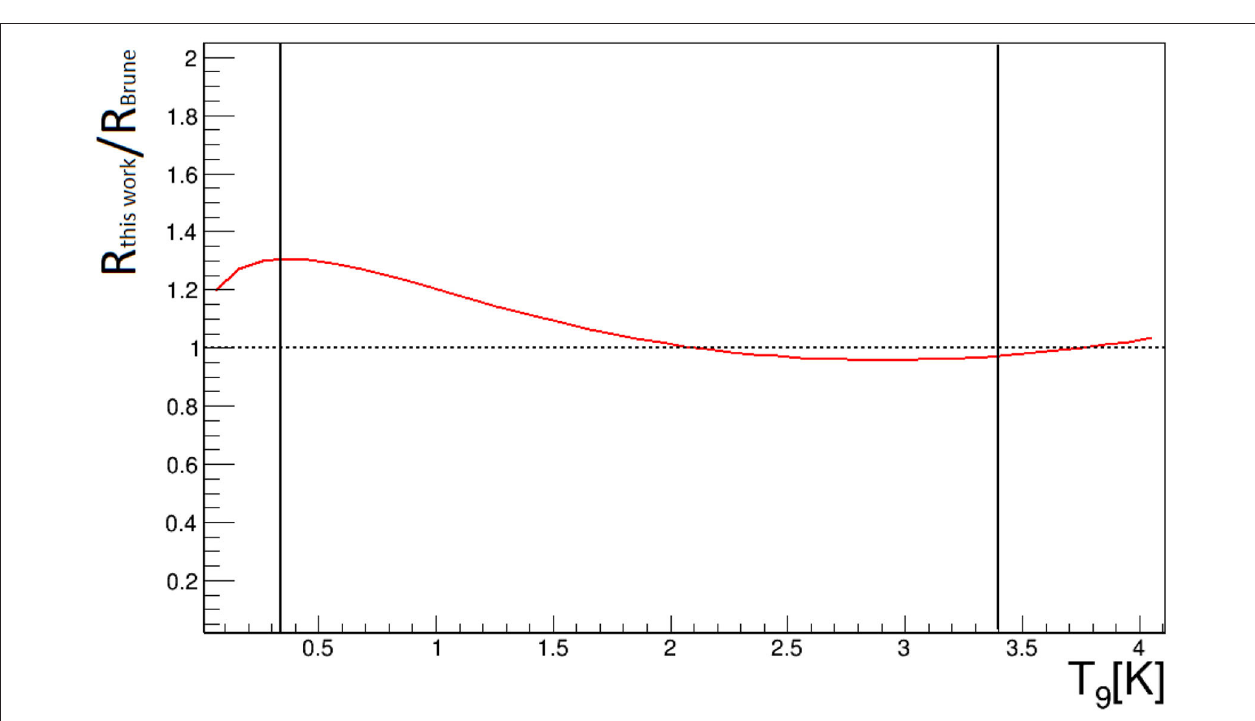
FIGURE 7 | Reaction rate for the 3 He(n,p) 3 H calculated from THM data (red line) reported in Pizzone et al. (2020) compared with the calculations from Brune et al. (1999). The black vertical lines mark the temperature interval important for BBN.